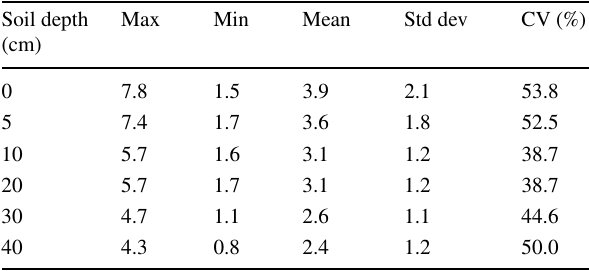
Fig. 2 Soil salinity variation at different soil depths in each of the eight irrigation blocks Table 3 Yield potentials (%) of selected crops as influenced by